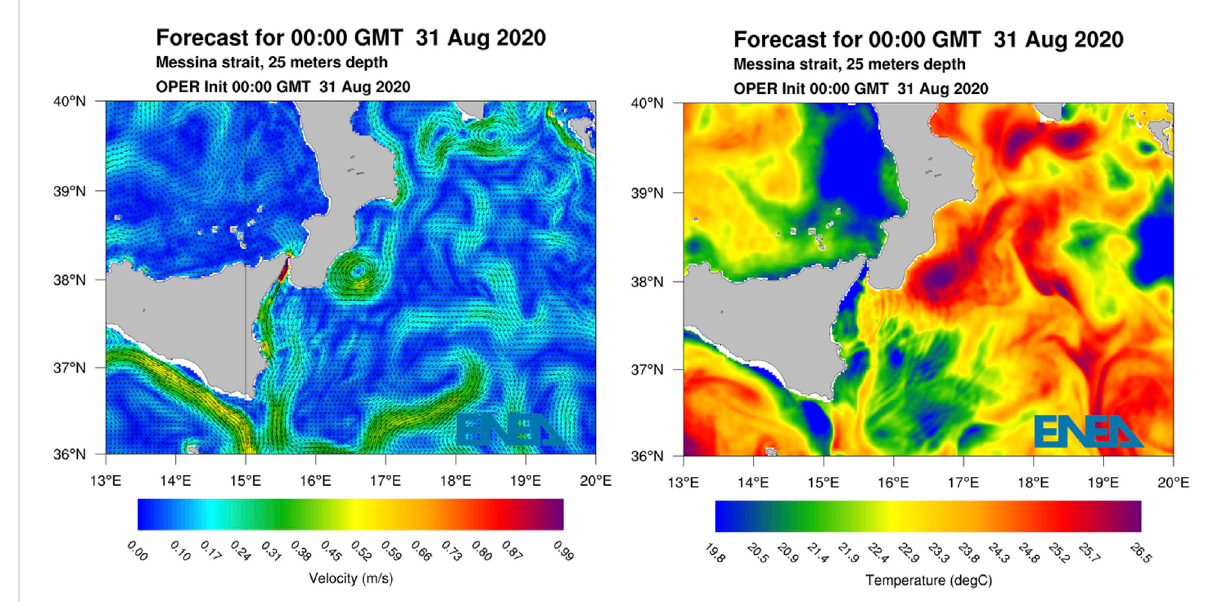
FIGURE 9 MITOmapsofcirculationandtemperatureat25 mofdepth,for31August2020,inawideregionaroundtheMessinaStrait.Themapsaretaken from the website (climaweb.casaccia.enea.it/mito) where daily forecast data from the operational system are made available for visualization